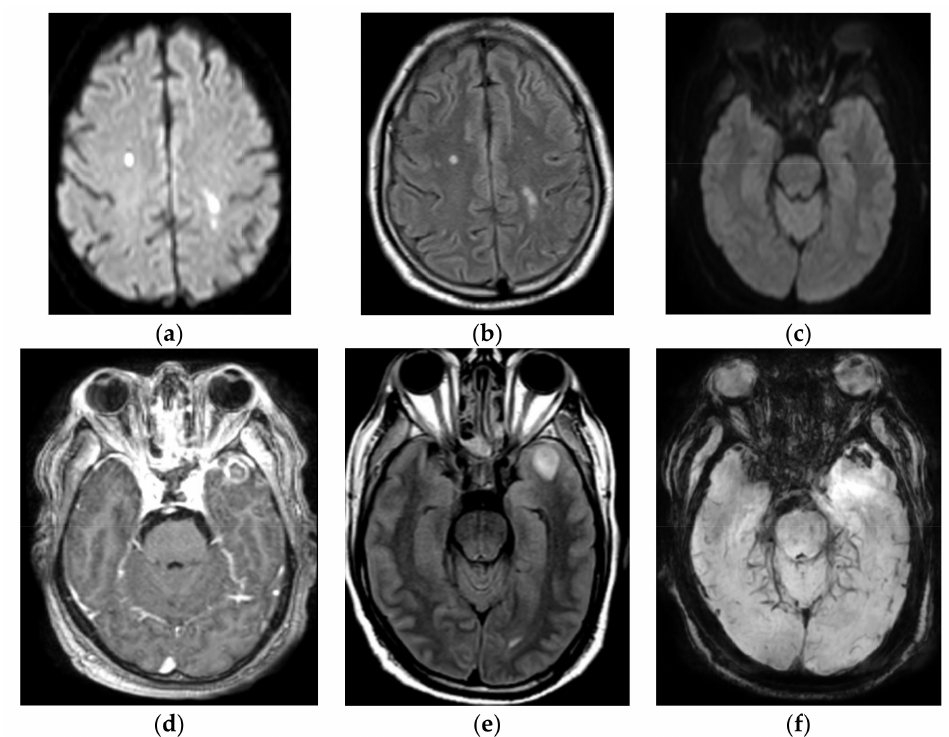
Figure 3. ( a – c ) Multiple acute infarcts. Multiple areas of restricting diffusion involving the right frontal and the left posterior frontal lobes on the b 1000 ( a ). Corresponding hyperintensities on FLAIR images ( b ). Restricted diffusion involving the left optic nerve on the b1000 ( c ). ( d – f ) Abscess in the left anterior temporal lobe. Peripherally enhancing lesion in the left anterior temporal lobe is seen on the post-contrast axial T1 image ( d ). Corresponding hyperintense signal on the FLAIR image ( e ) and susceptibility artifact on SWI images ( f